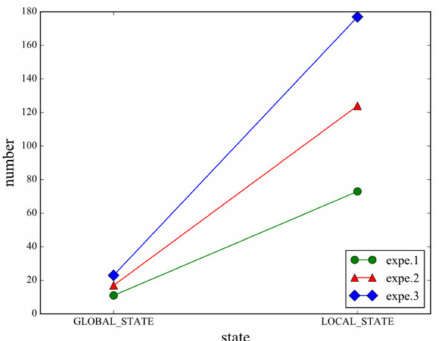
Figure 9. The number of global and local states of nodes in the three